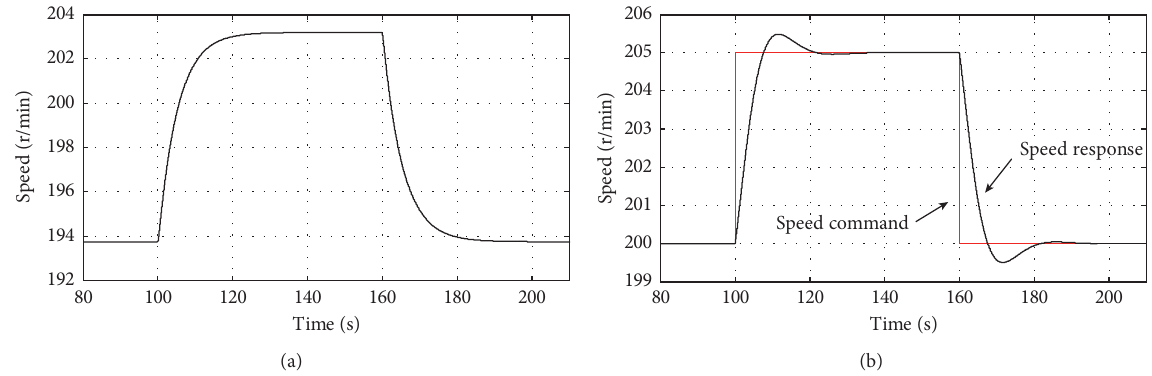
Figure 37: Comparison diagram of the speed. (a) Power priority control strategy. (b) Speed priority control strategy.